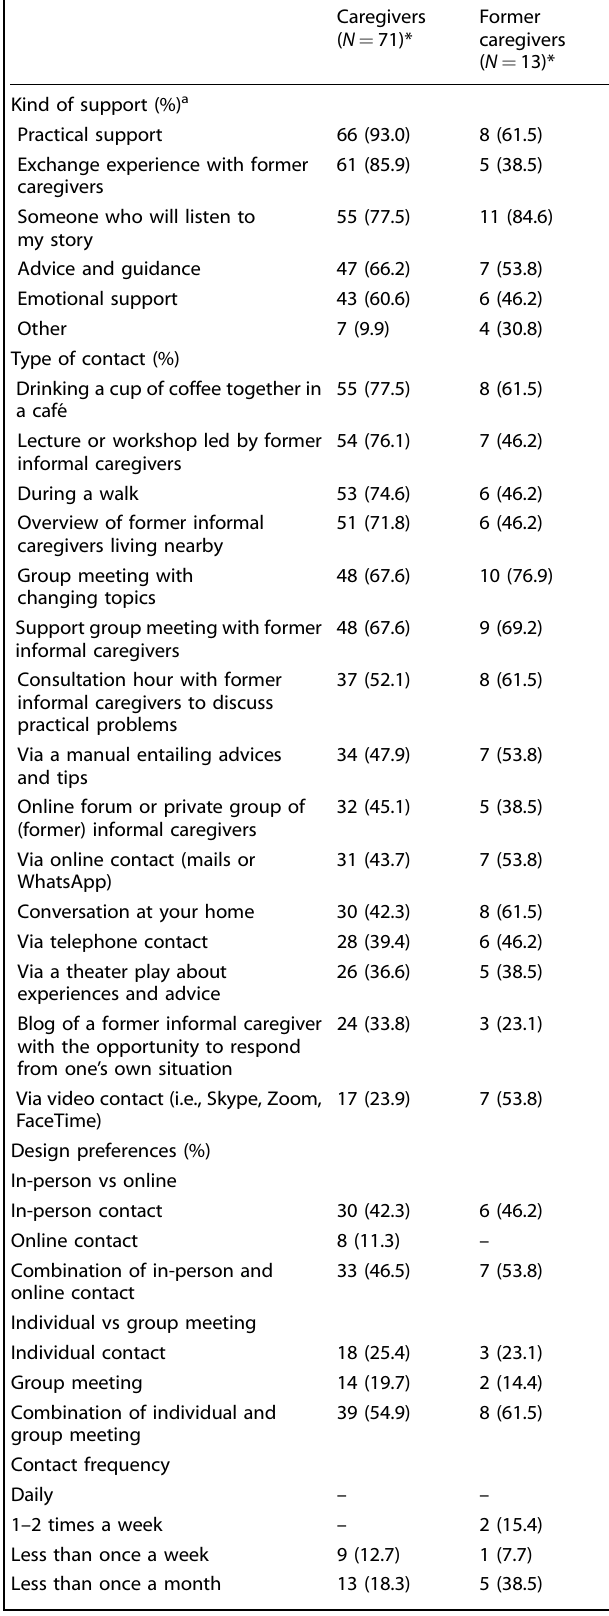
Table 4. Setting, form and conditions for a peer-to-peer intervention connecting current and former informal